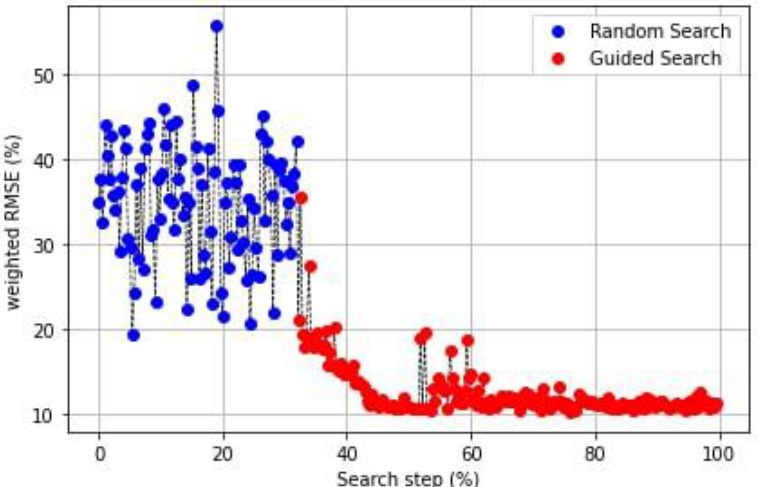
Figure 4. RMSE profile in the two phases (exploration (blue) and exploitation (red)) of the searching performed by the implemented Bayesian algorithm.